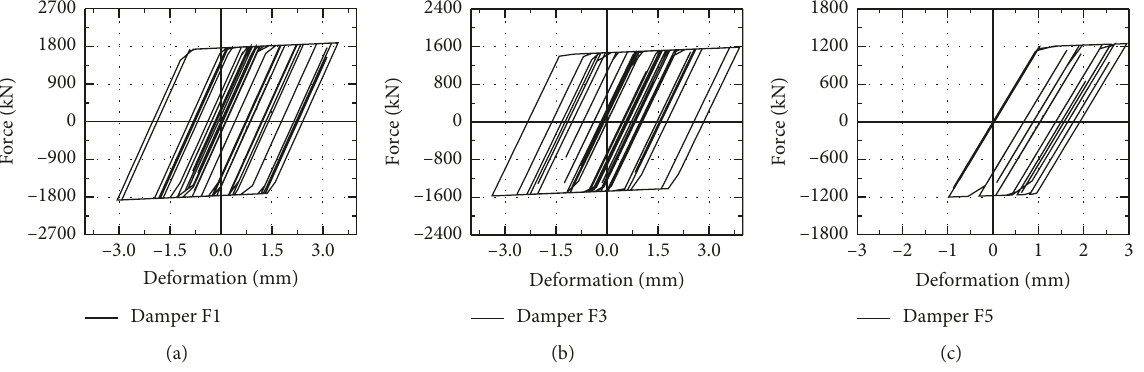
Figure 8: Hysteresis curves of MYDs under AW1: (a) damper at story 1; (b) damper at story 3; (c) damper at story